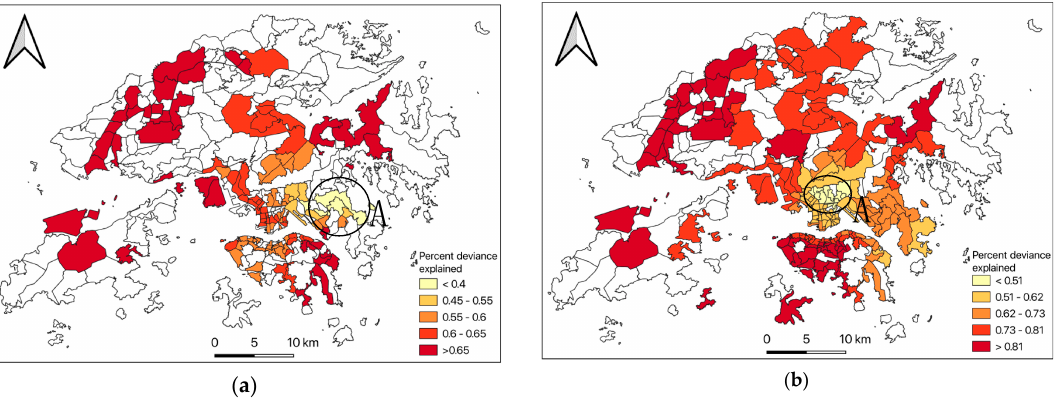
Figure 6. Spatial distribution of local percent deviance explained by the GPWR models for R1 and R2: (a) Local percent deviance explained R1; (b) Local percent deviance explained R2.